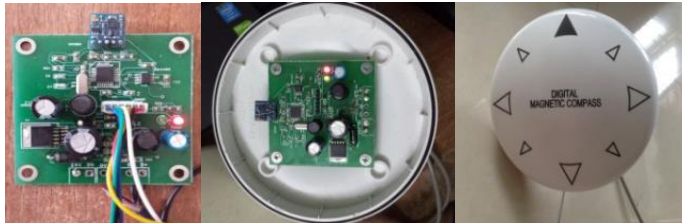
Fig. 2. DMC device model.